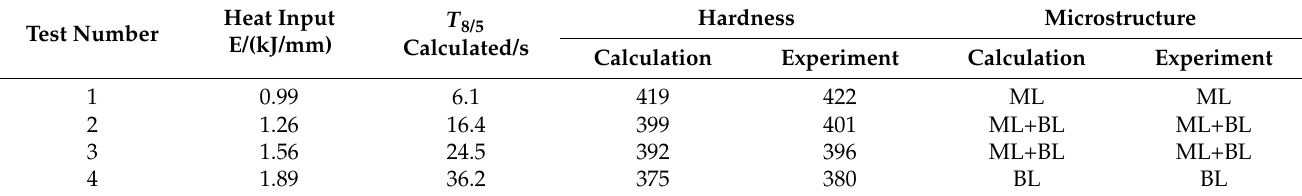
Table 4. Comparation of microstructures and hardness obtained by simulation and